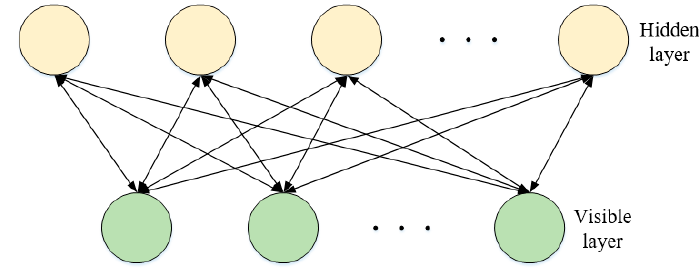
Figure 4. Example structure of a restricted Boltzmann Figure 4 . Example structure of a restricted Boltzmann machine .